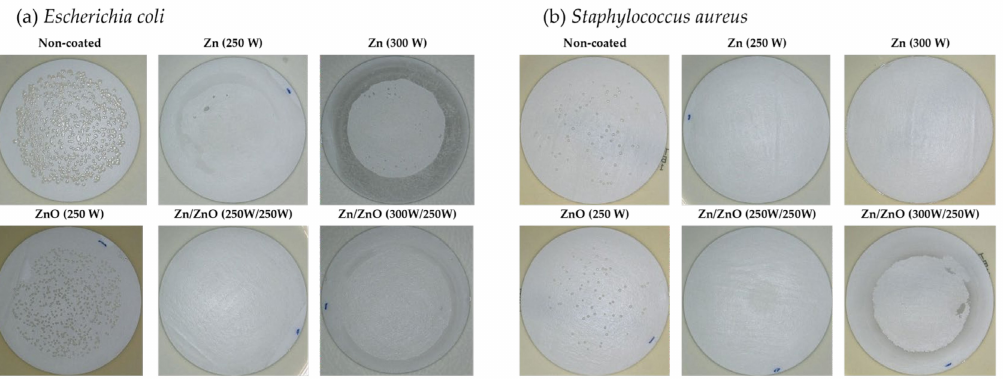
Figure 4. The results of 3D microscope images obtained for antibacterial activity of one-component and two-component coatings against bacteria: ( a ) Escherichia coli ; ( b ) Staphylococcus aureus